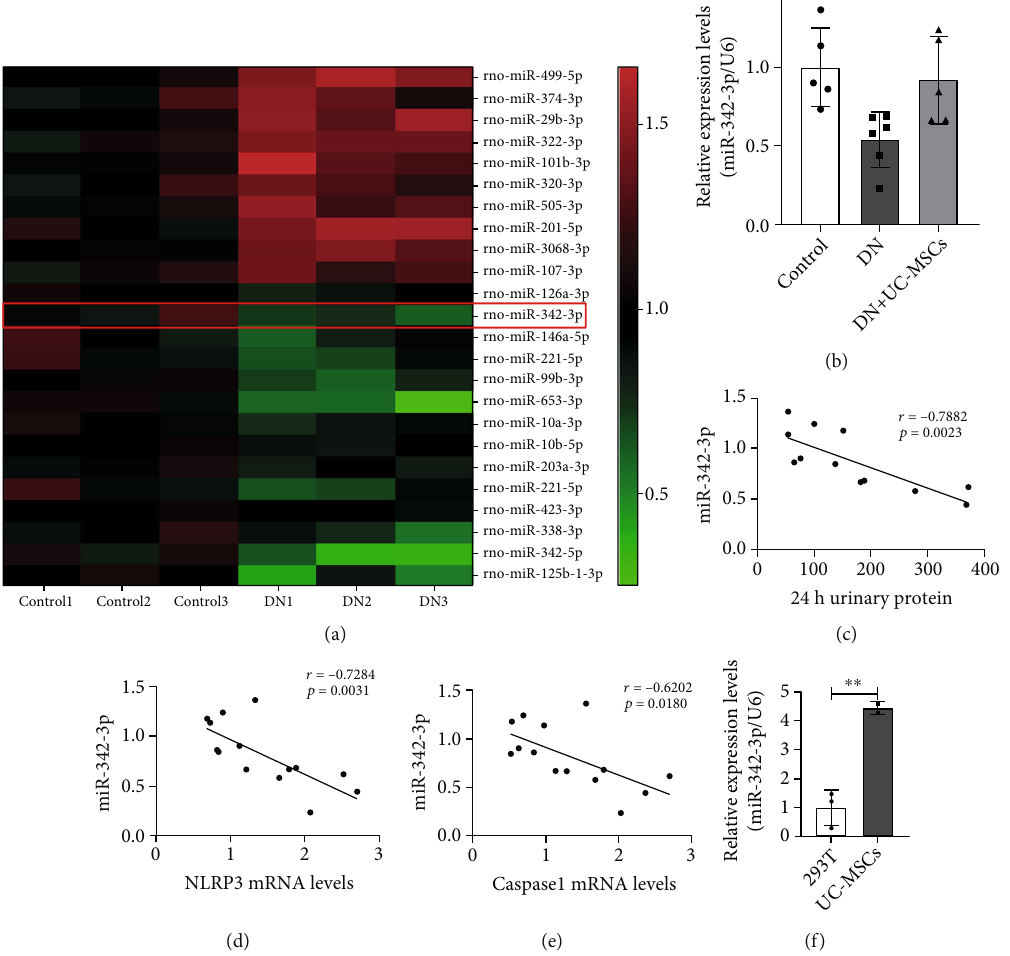
Figure 5: miR-342-3p is identi fi ed as the most closely related to pyroptosis and DN. (a) Heatmap of mRNA sequencing data from the control and DN groups (green, downregulated; red, upregulated); miR-342-3p was downregulated in the kidney of DN rats. (b) RT-PCR analyzed expression of miR-342-3p in the control, DN, and DN+UC-MSC groups ( n = 4 – 6 rats per group). (c) Correlations of miR- 342-3p expression with 24 h urinary protein in rats, n = 12 rats. (d, e) Correlations of miR-342-3p expression with mRNA levels of Caspase1 and NLRP3 ( n = 11 – 13 rats). (f) RT-PCR analyzed expressions of miR-342-3p in HEK293T and UC-MSCs. Data are expressed as means ± SD . ANOVA was used for comparison among multiple groups. ∗ p < 0 : 05 and ∗∗ p < 0 : 01